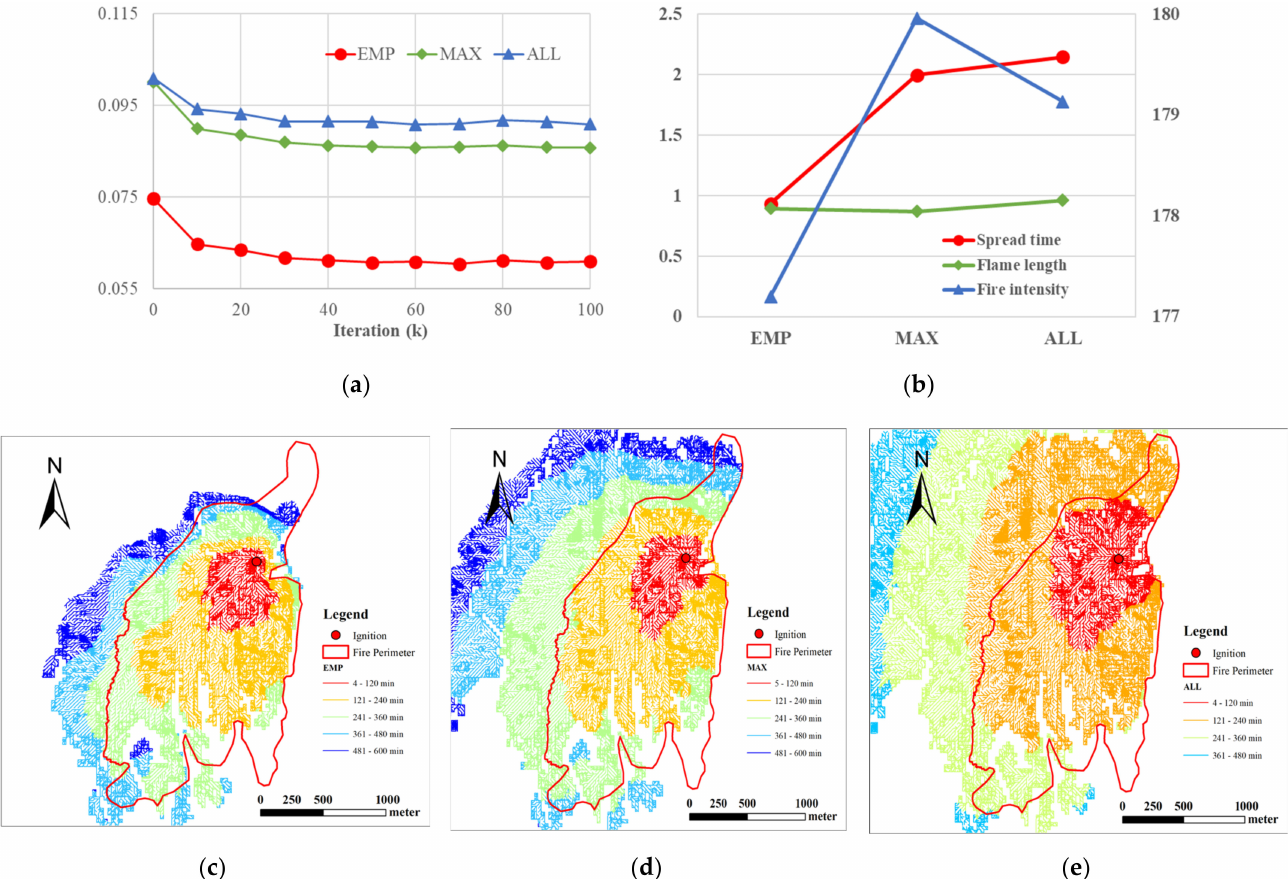
Figure 11. Comparison of different VSE dataset construction. ( a ) Training curve; ( b ) test error; ( c ) empirical method; ( d ) maximum time method; ( e ) all-extraction